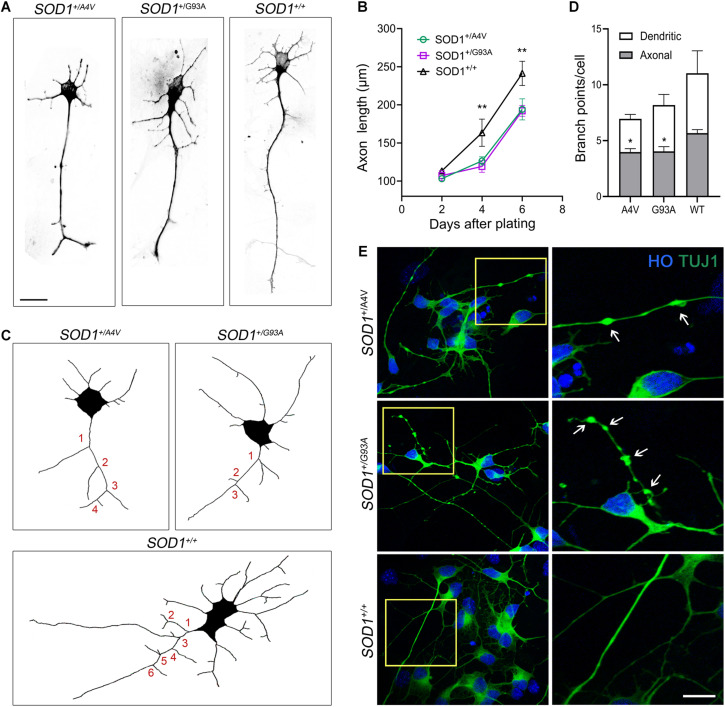
Axonal pathology and dystrophic neurites in SOD1+/A4V and SOD1+/G93A MNs. (A) Representative images of MNs showing different axonal lengths. Scale bar, 20 μm. (B) Quantification of average axonal length. n = 3 biological replicates for each time point (a total 556 cells with SOD1+/A4V mutation, 429 cells with SOD1+/G93A mutation, and 397 cells with SOD1+/+ were evaluated). (C) Representative images of Tau+ axon tracing. Numbers in red indicate axonal branch points in each line. (D) Quantification of dendritic and axonal branch points on 6 day postplating. n = 4 biological replicates (a total of 258 cells with SOD1+/A4V mutation, 186 cells with SOD1+/G93A mutation, and 176 cells with SOD1+/+ were evaluated). (E) Representative images of dystrophic neurites with swelling in the MN cultures on day 28. Arrows indicate swollen beads. Scale bar, 10 μm. All data shown as mean ± SEM. *p < 0.05, **p < 0.01.